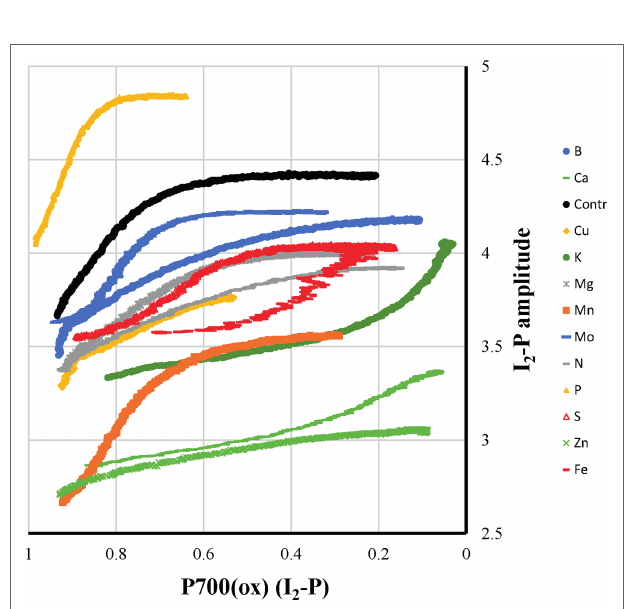
FIGURE 9 | Relationship between Pm and I 2 -P amplitude for plants exposed to 12 mineral deficiencies. The colors reflect the different classes: yellow, electron transfer between cyt b 6 f and P700 affected; green, PS I acceptor side damage; red, FeS-cluster synthesis affected; blue, feedback inhibition; and gray, mixed states. Further, Mn-deficiency is orange, and the Control is black. The data represent averages of four independent measurements.